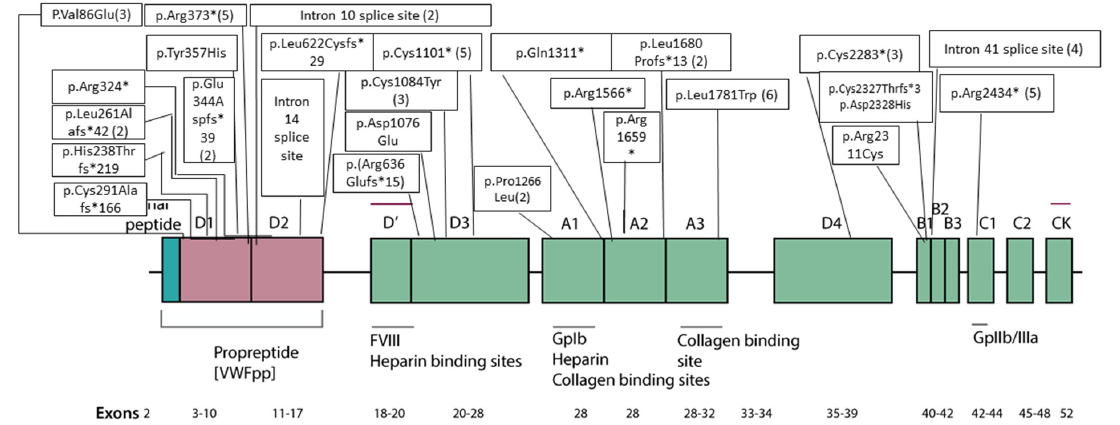
Figure 1. Mutations in different regions of VWF gene with respect to exon, domains of protein and bindings sites. The lowest line shows the exon arrangement. Above than the exon arrangement functional binding sites/protein. Domains of the VWF gene are represented in color boxes. Amino acid changes, truncations and splice site mutations are expressed in plain boxes. Number of patients having particular mutation is given in brackets against each amino acid change, termination or splice site mutations.